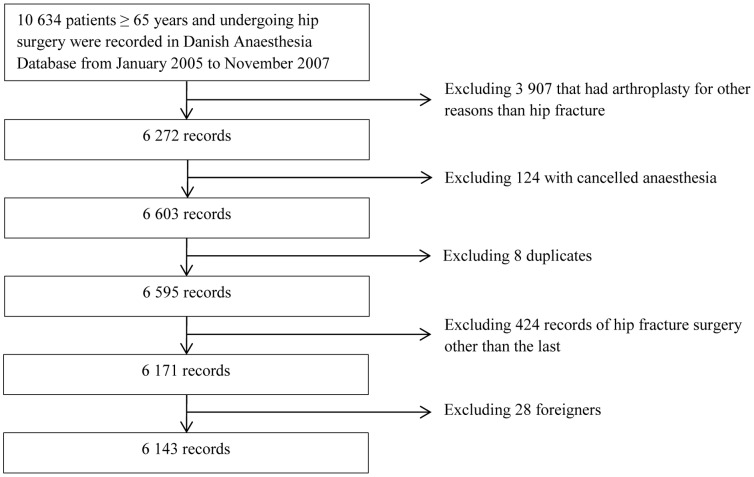
Selection of the study cohort.